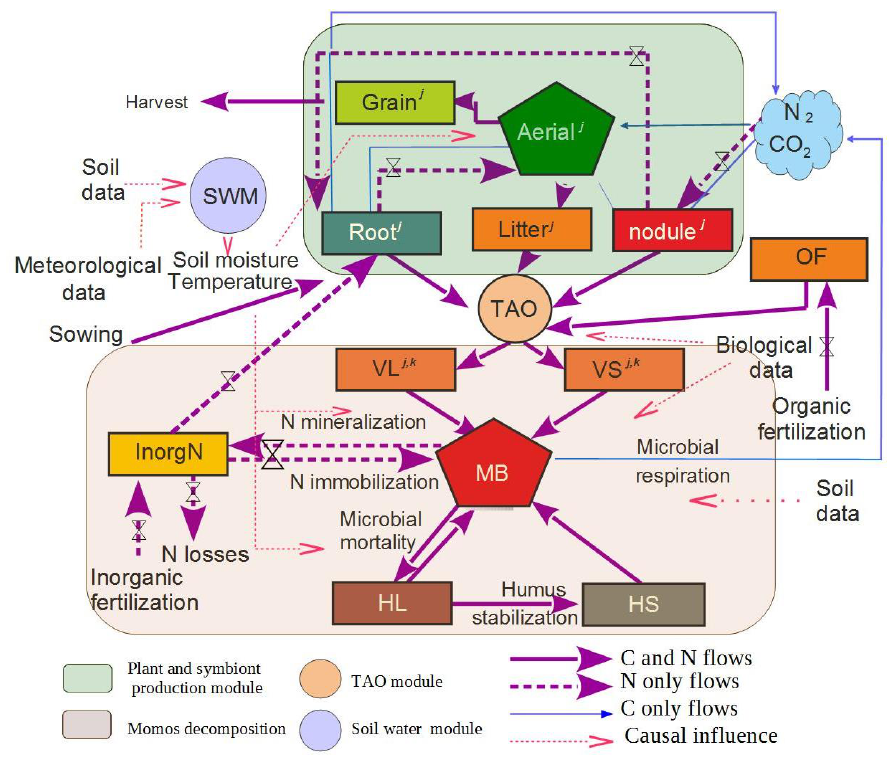
Figure 1. The MOMOS model (microorganisms and organic matters of soils): coupling the decompo- sition and vegetal production in connection with soil climate, biological data (TAO, transformation of added organic matters), and soil texture. MB is microbial biomass, VL j,k and VS j,k are labile and stable fractions of each organ k of plant j or organic fertilizer OF. HL and HS are labile and stable humus, respectively, inorgN is the inorganic N continuously exchanged with the MB and roots of plants. SWM is the soil water module associated with organic